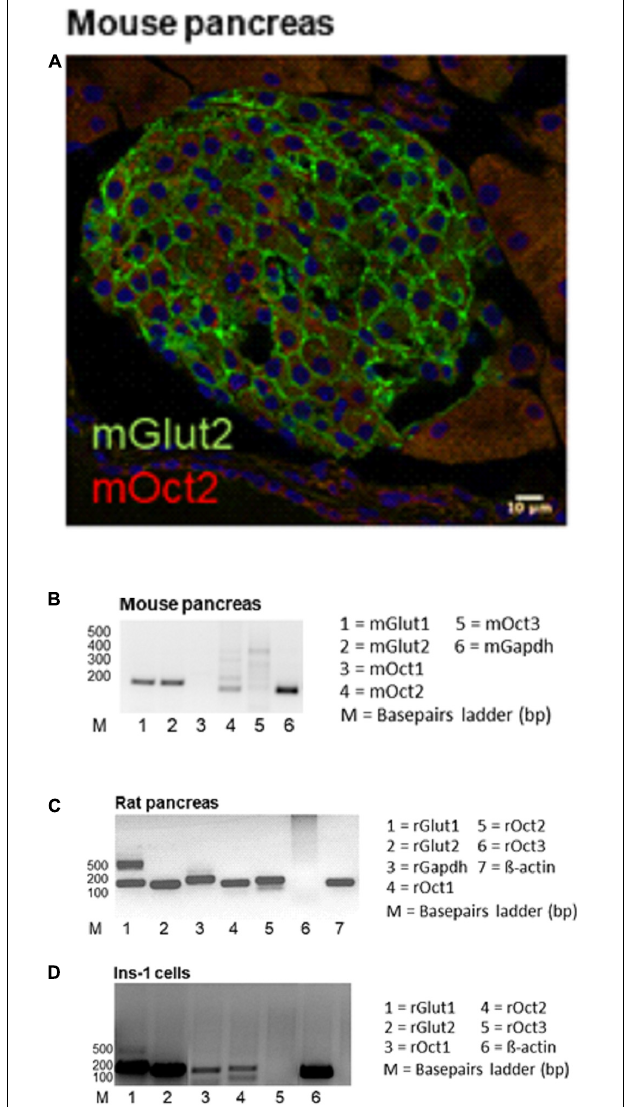
FIGURE 1 | This figure shows the expression of GLUT and OCT in the pancreas. In panel (A) a representative immunofluorescence analysis of GLUT2 (green) and OCT2 (red) expression in a mouse pancreatic islet is shown. GLUT2 is evident in the plasma membrane of islet cells. OCT2 seems to be expressed in intracellular compartments of some islet cells. No GLUT2/OCT2 co-localization is observed. Panel (B) shows that mouse pancreas expresses mRNA of GLUT1 and 2 and of OCT2, but not of OCT1 and 3. For OCT2 several bands are visible, but sequencing confirmed the identity of the lower band with OCT2. In rat pancreas (C) OCT expression became visible only after reamplification. However, this reamplification caused the appearance of an unspecific band for GLUT1. Sequencing confirmed the lower band to be specific for GLUT1. The INS-1 cells show the same transporter expression pattern as the rat pancreas (D)